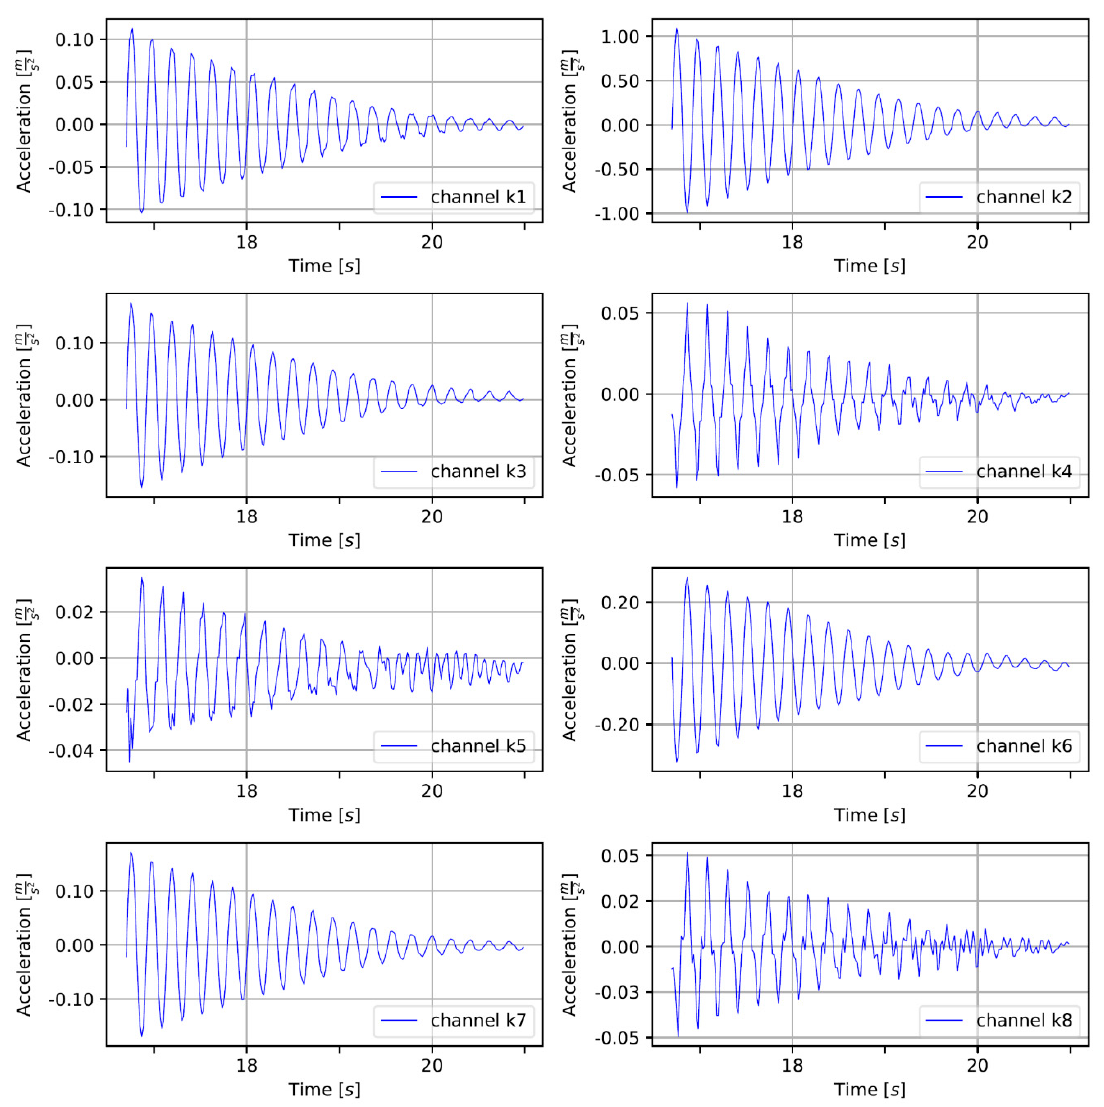
Figure 11. Acceleration measurements at points K1L to K8L during natural vibrations of the left gates’ leaf.